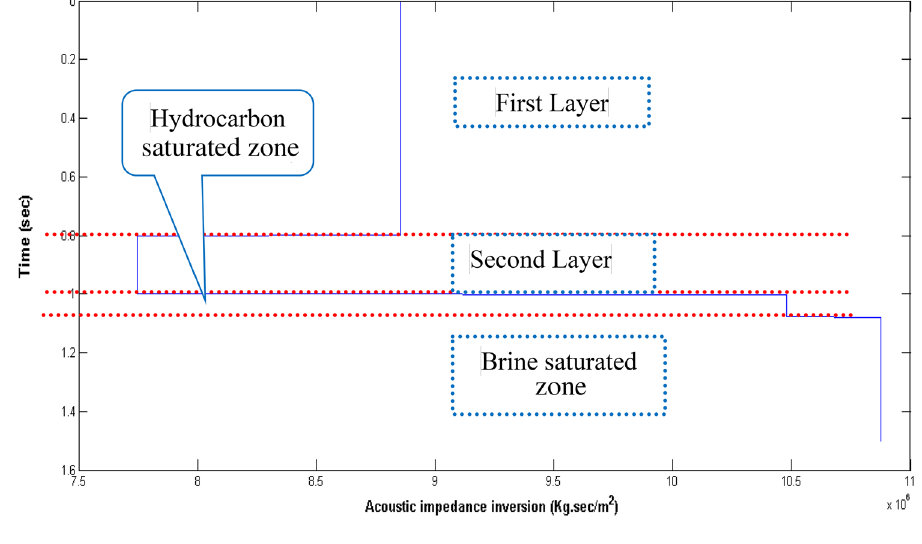
Fig. 8 Acoustic impedance plot of case